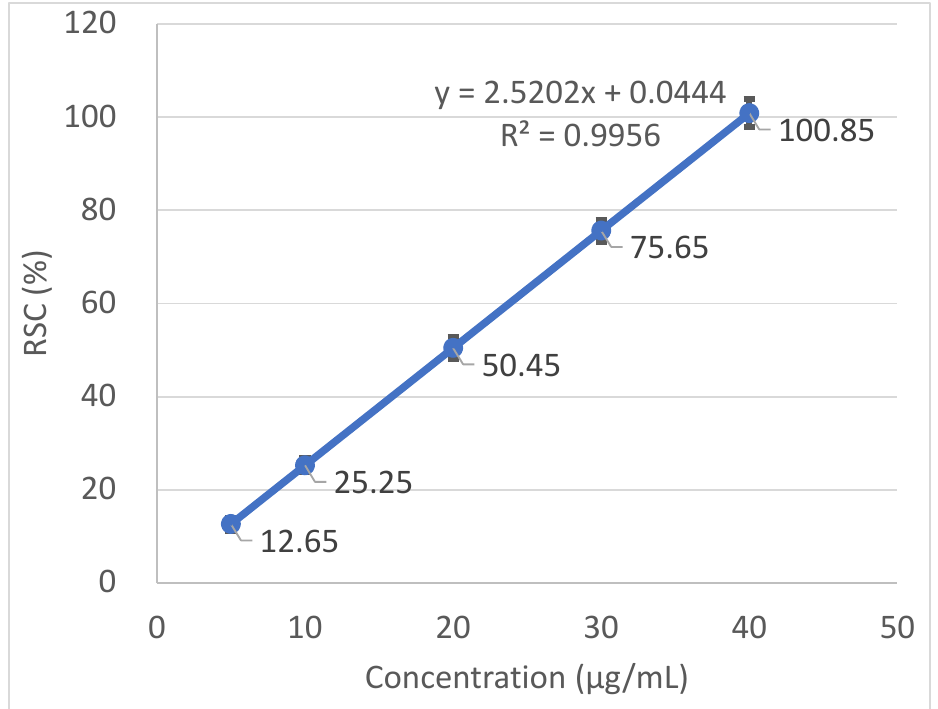
Figure 2. Radical scavenging activity determined in the Trolox antioxidant standard solution. The inhibitory concentration was plotted against the free radical scavenging activity measured in the samples. The radical scavenging activity of the methanol extract samples was calculated using the linear ( y = a x + b) equation plotted with the DPPH values, with the Y -value being 50 and the X -point being the IC 50 value. The value was expressed as micrograms of Trolox equivalents per mL of methanol extract.